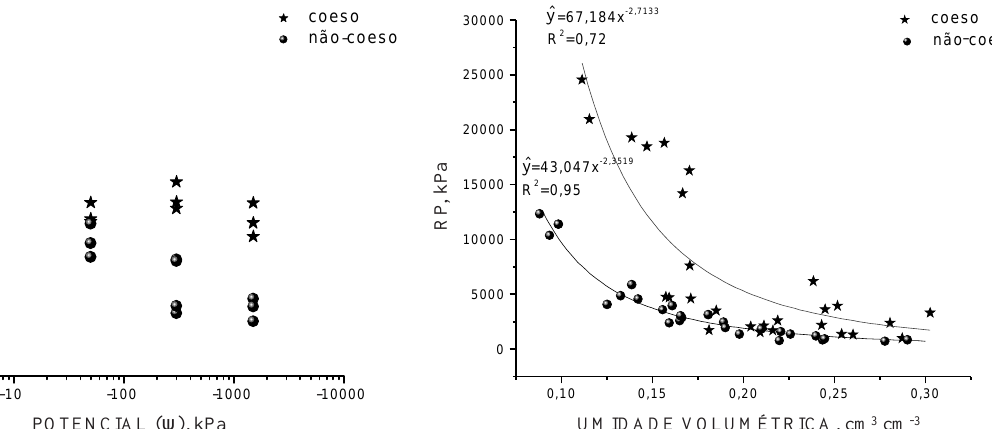
Figura 3. Resistência do solo à penetração versus umidade volumétrica nos horizontes: coeso e